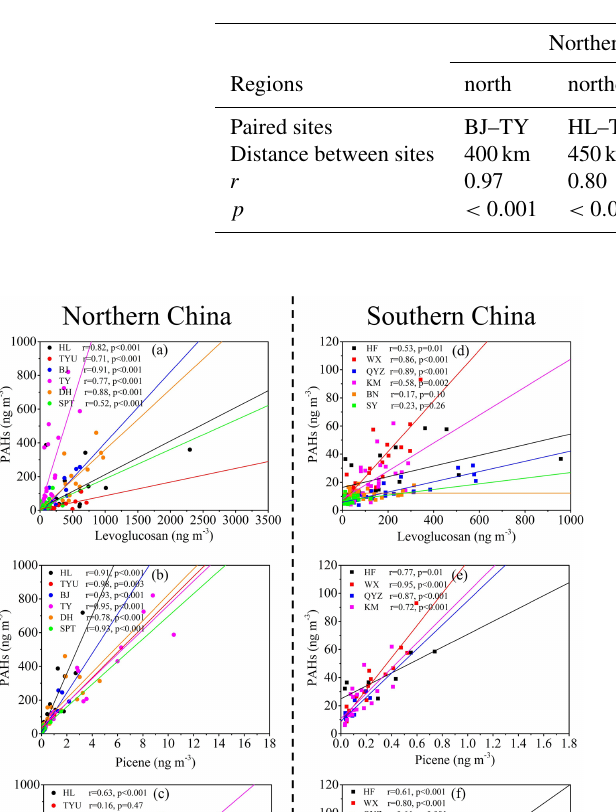
Table 2. Correlation coefficient ( r ) and significance ( p ) of PAHs between paired sites in each region.